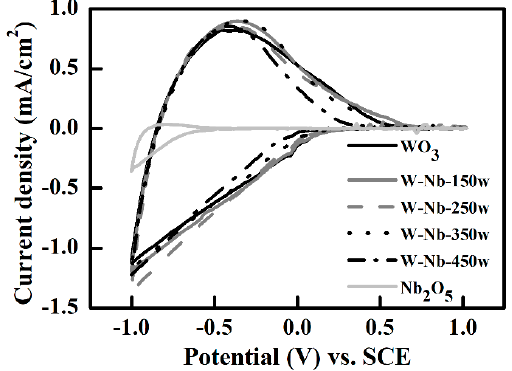
Figure 9. Cyclic voltammograms for WO 3 , WO 3 –Nb 2 O 5 , and Nb 2 O 5 films.